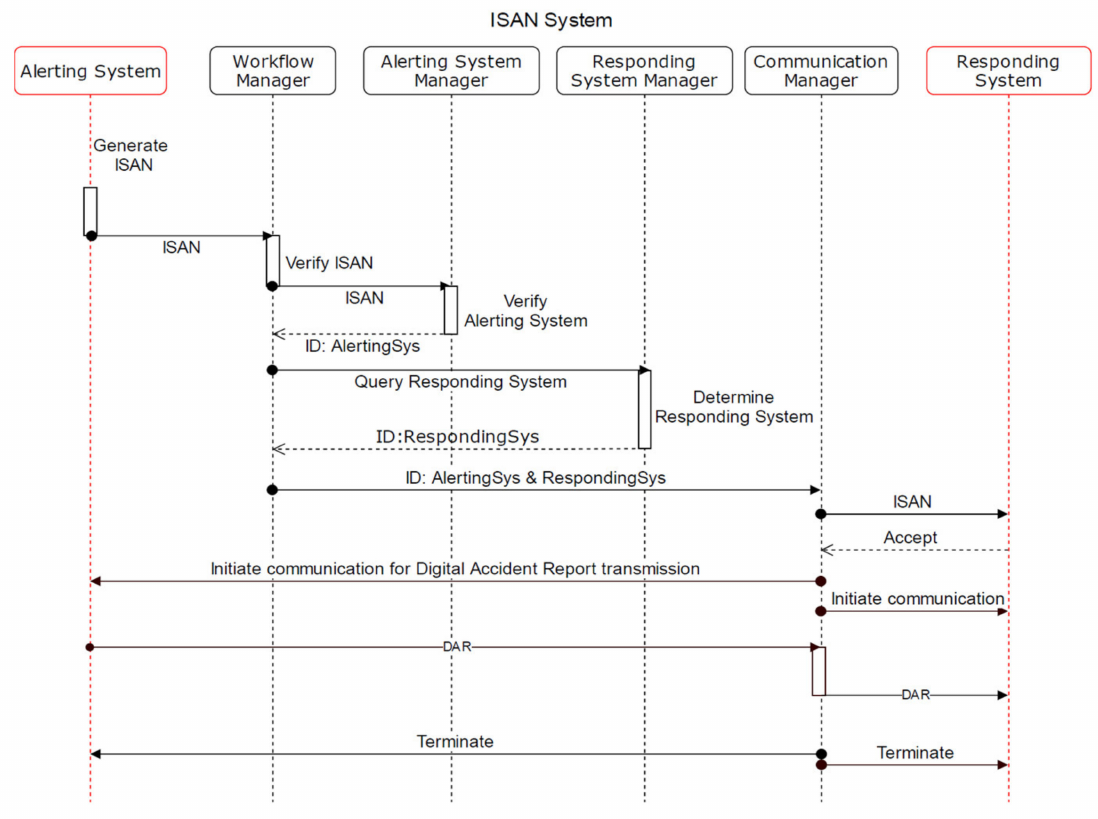
Figure 3. Alerting system actively transfers data to responding system. The workflow of both scenarios is similar. The difference lies in the starting and ending point. The following description corresponds to Figure